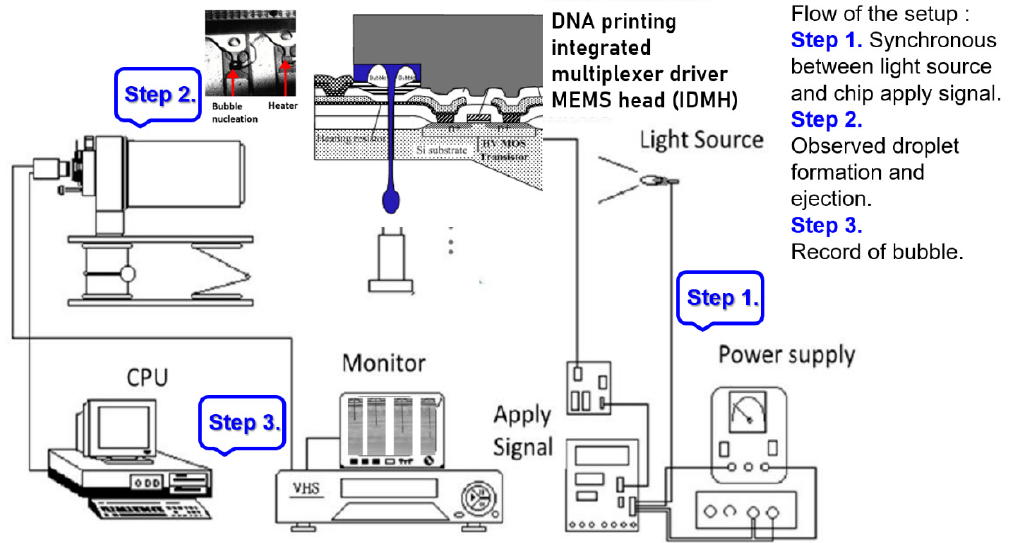
Figure 1. The system uses CCD to capture images. The process of bubble from nucleation, growth, bubble generation to dissipation (Flow of the setup: Step 1. Synchronous input power signal (for light source) and chip drive pulse (Apply signal), Step 2. Observe droplet formation and ejection trajectory through a microscope Observe droplet formation and ejection trajectory through a microscope, Step 3. Process record of bubble from nucleation, growth, bubble generation to dissipation).